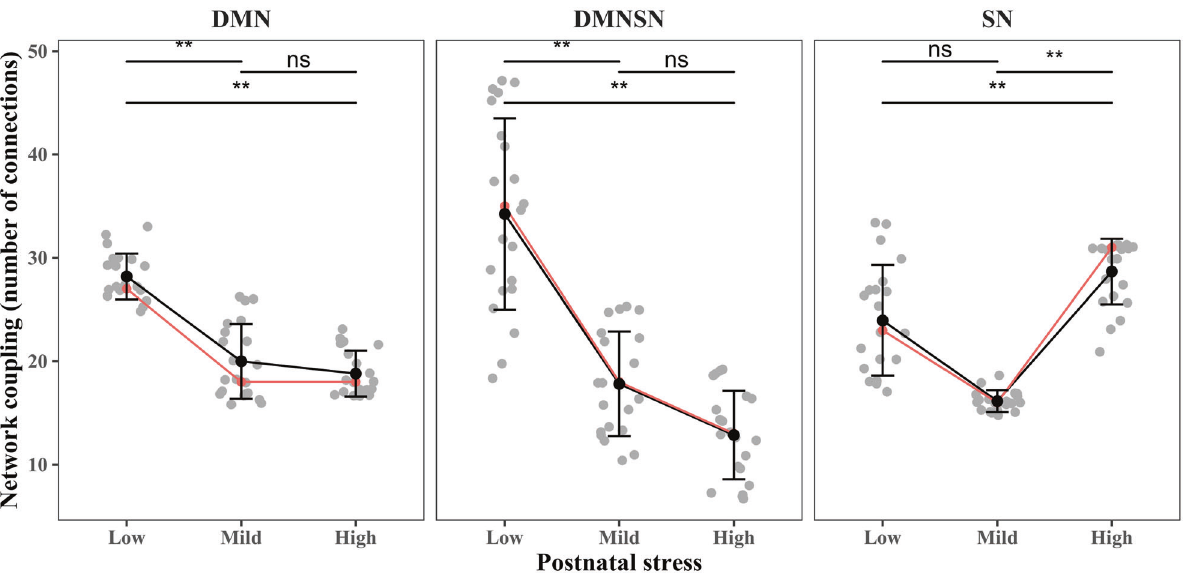
Fig. 4 Differences in structural coupling for low (<33.3%), mild (33.3 – 66.6%), and high-stress-exposed infants (>66.6%). Observations are the number of connections using different density thresholds with mean (black dots) and standard deviation (error bars). The orange line depicts structural coupling at a network sparsity of 20%. DMN default mode network, SN salience network. ** P < 0.01, ns non-signi fi parahippocampal gyrus and bilateral anterior fusiform (left: Z = − 12.41; right: Z = − 15.23, p-FDR < 0.001), among others. Signi fi cant lower maturational coupling was observed in infants exposed to high stress between several DMN-SN regions. Analyses revealed a lower coupling between the left insula and right posterior parahippocampal gyrus ( Z = − 16.04, p-FDR < 0.001) and between the left insula and right posterior fusiform gyrus ( Z = − 17.91, p-FDR < 0.001). In addition, high-stress-exposed infants showed decreased synchronized development between the bilateral anterior cingulate cortex and the right posterior parahippocampal gyrus (left: Z = − 3.75, p-FDR < 0.001; right: Z = − 3.29, p-FDR < 0.001). A schematic representation of the altered within- and between-network maturational coupling is shown in Fig. 5. For a complete overview of region-level alterations, see Supplementary Table 1.